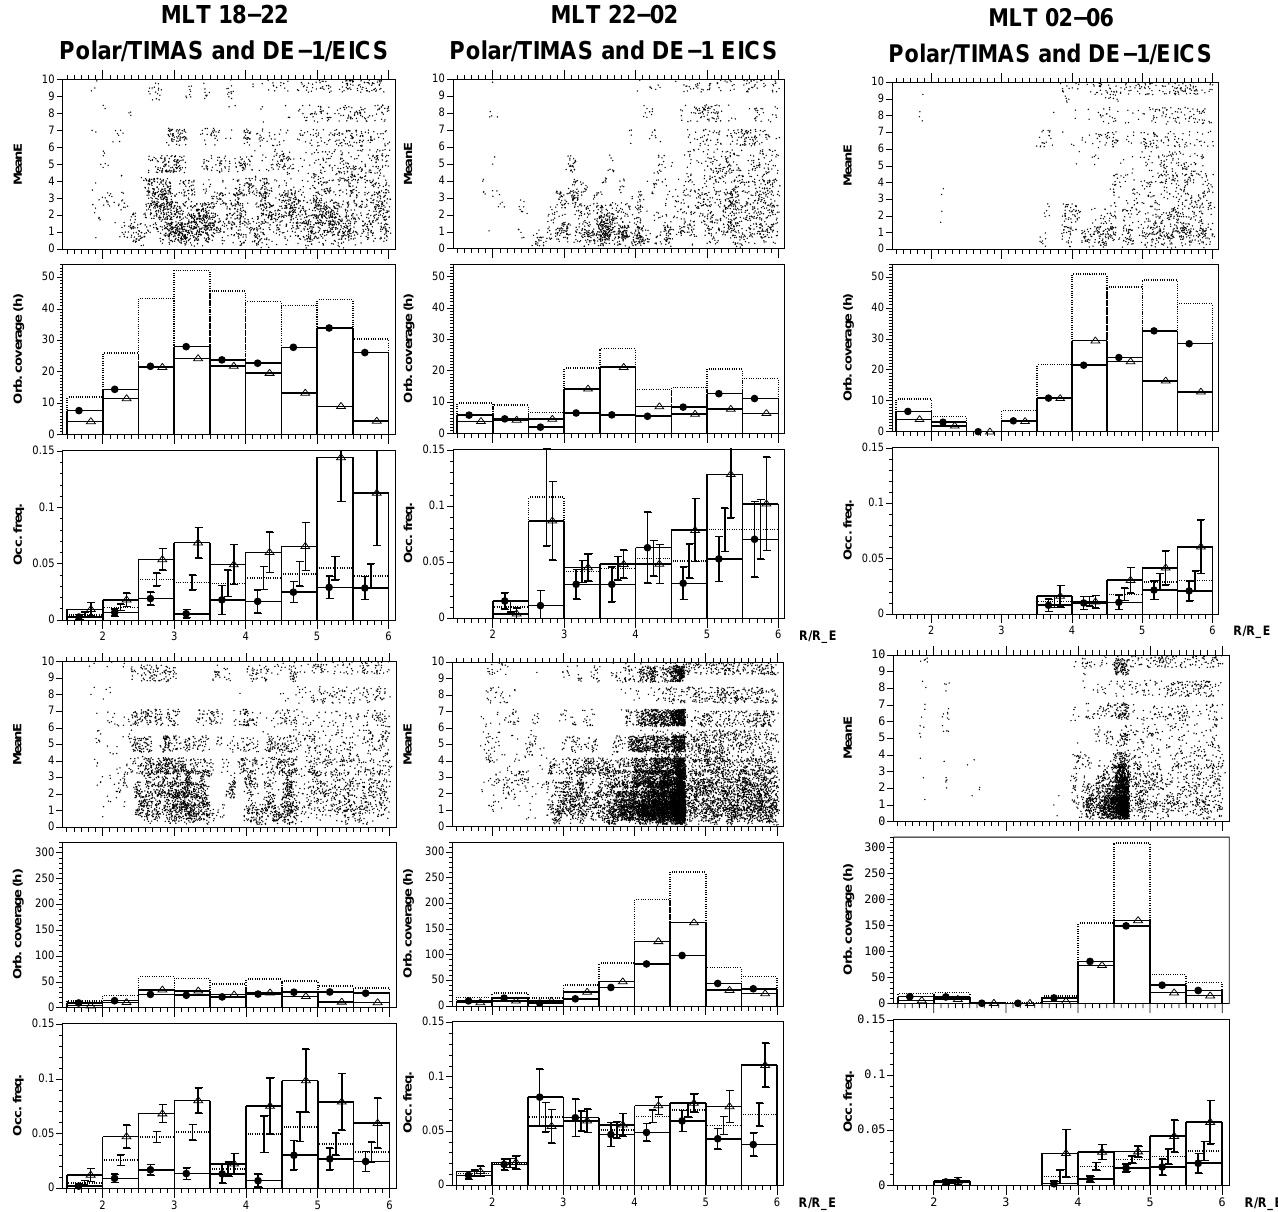
Fig. 4. Same as Fig. 3, but separated in the three nightside MLT sectors with sunlit (top) and darkness (bottom) conditions.